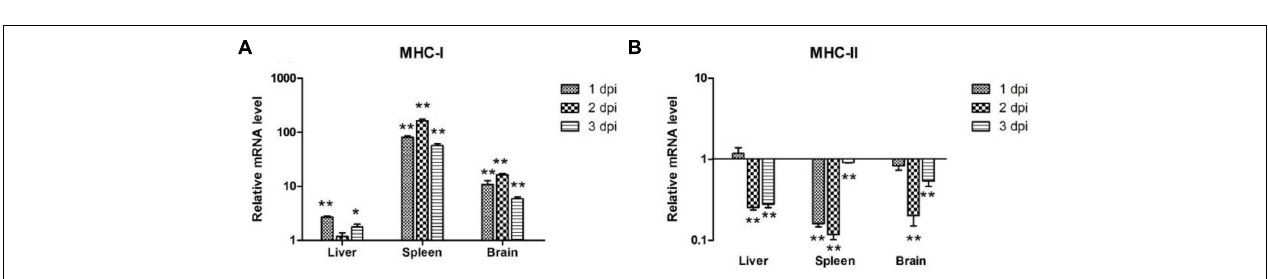
FIGURE 3 | The expression of avian β -defensins (AvBDs) in the liver, spleen, and brain from the APEC-infected ducks. (A) AvBD2, (B) AvBD4, (C) AvBD5, (D) AvBD7, (E) AvBD9, (F) AvBD16. Y -axis represents the fold change of target genes in the experiment groups versus those in control group. Data were expressed as means ± standard deviations ( n = 3). The difference was calculated by the Student’s t -test. ∗ P < 0.05, ∗∗ P < 0.01.